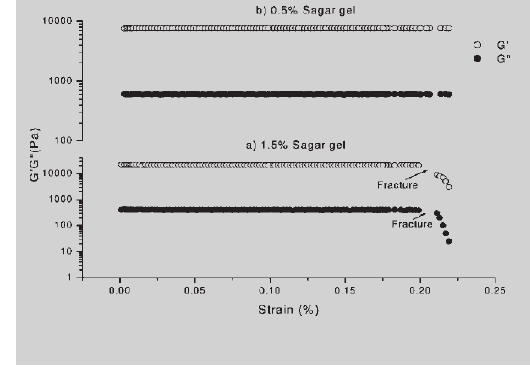
Figure 3: Strain dependence of G’ (blank circle) and G’’ (solid circle) for a) 1.5% w/v agar gel and b) 0.5% w/v agar